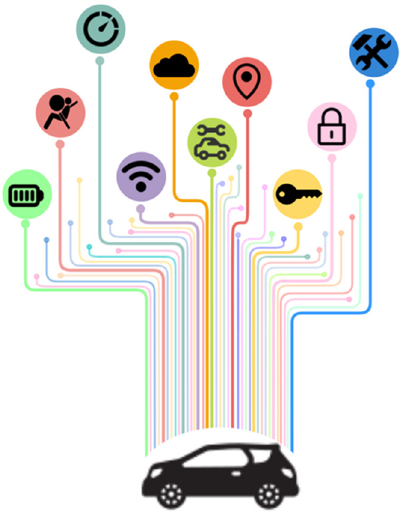
Figure 5. IoT devices integrated in vehicles.